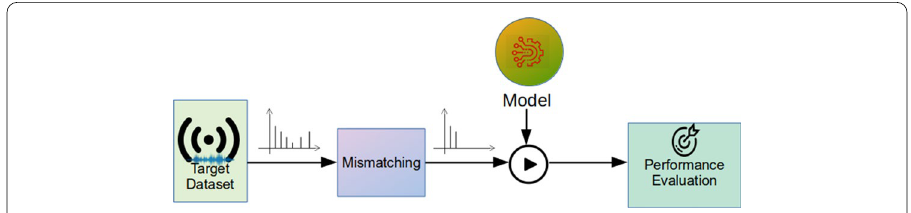
Fig. 18 Mismatching experiment process